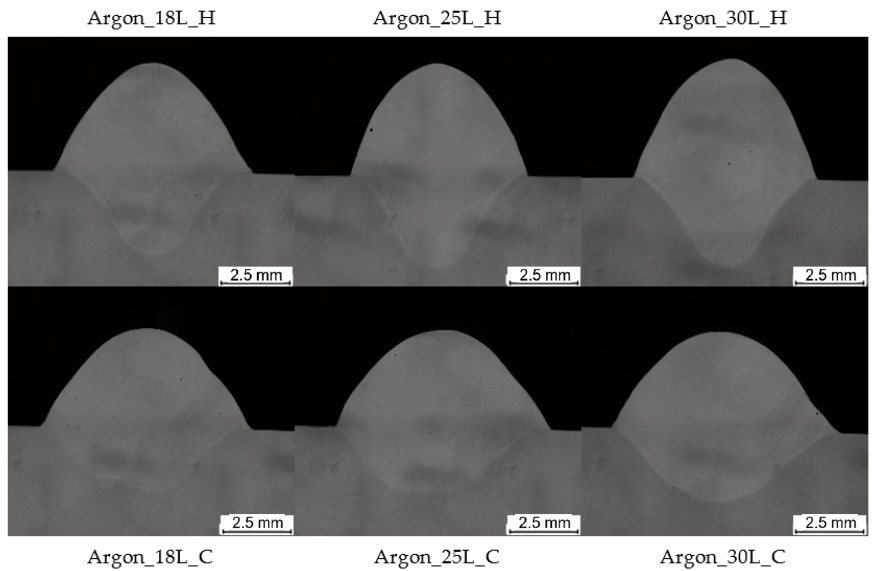
Figure 4. Cross-sections of single weld beads with cold metal transfer (CMT) and Argon Q1 shielding gas.